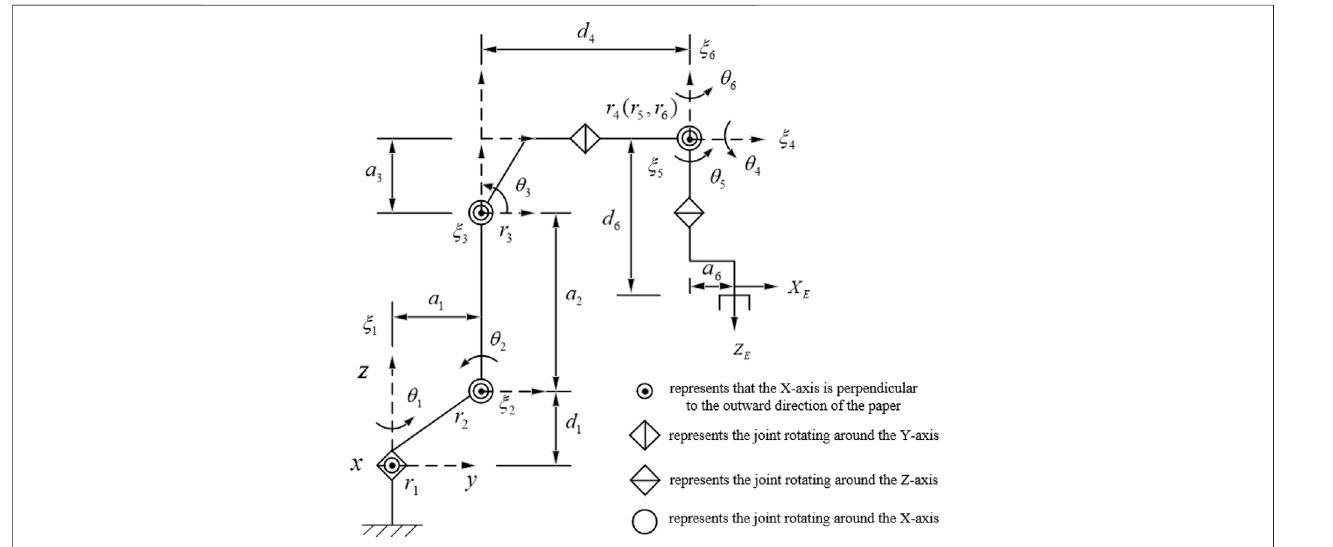
FIGURE 1 | Sketch of general industrial six-degree-of-freedom robotic arm structure.